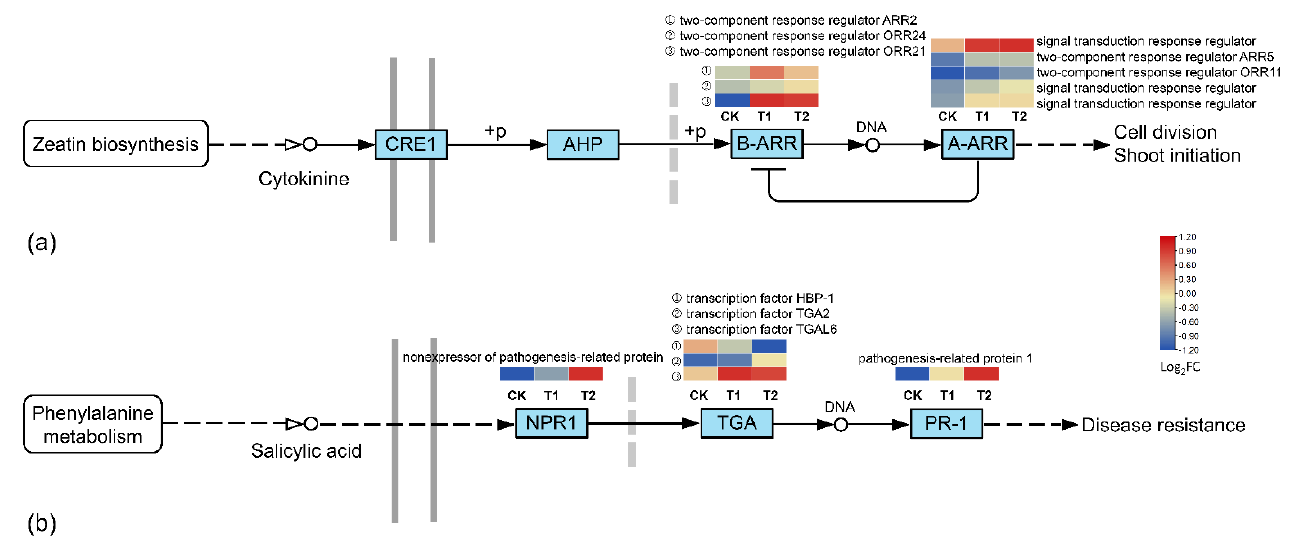
Figure 6. Enriched KEGG pathway terms involved in plant hormone signal transduction ( a ): cy- tokinin; ( b ): salicylic acid) after heat stress in Michelia macclurei . The expression level of the DEGs is shown in the heatmap beside the key nodes in each pathway; the change from blue to red means the expression level is going from low to